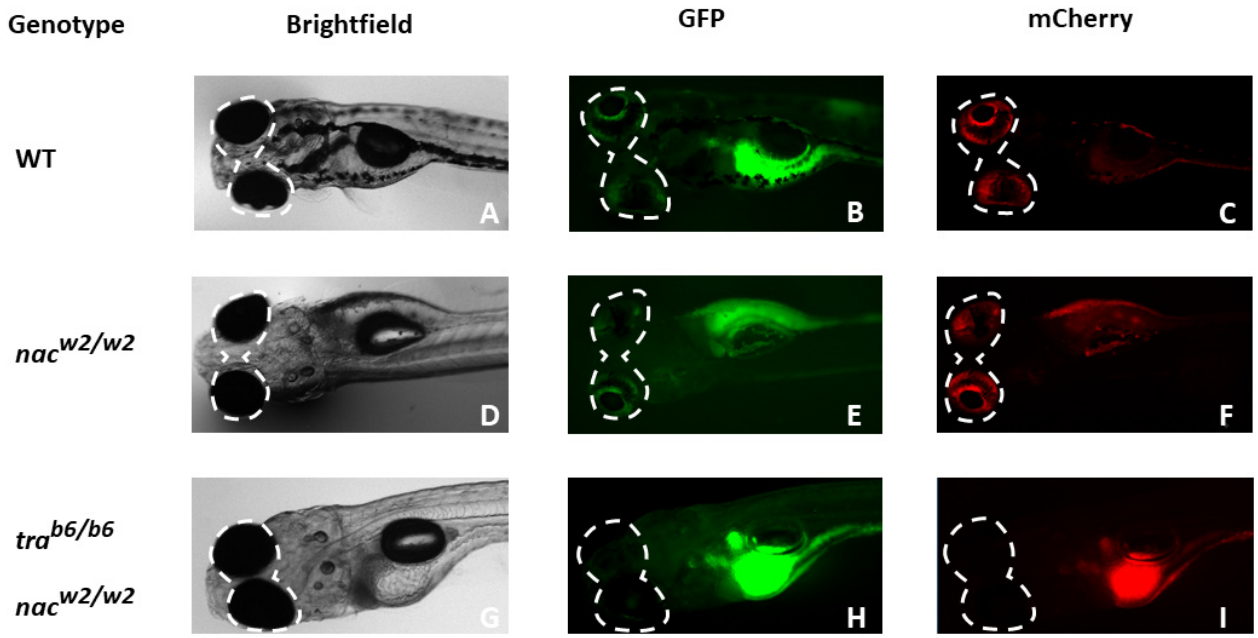
Figure 3. Larval zebrafish screening at 5 dpf using fluorescent microscopy and investigation of eye autofluorescence caused by iridophores. Using different channels (brightfield, GFP and mCherry), different patterns of colouration in the zebrafish eye become apparent between TraNac zebrafish larvae ( I ), in contrast to both nac ( E ), and WT ( C ) larvae. Although both fluorescent channels, GFP and mCherry appear to be equally useful for screening for eye pigmentation, by experience, the red fluorescent mCherry channel is easier for distinguishing in practice. nac = nacre, roy = roy orbison, tra = transparent , WT = wild-type.